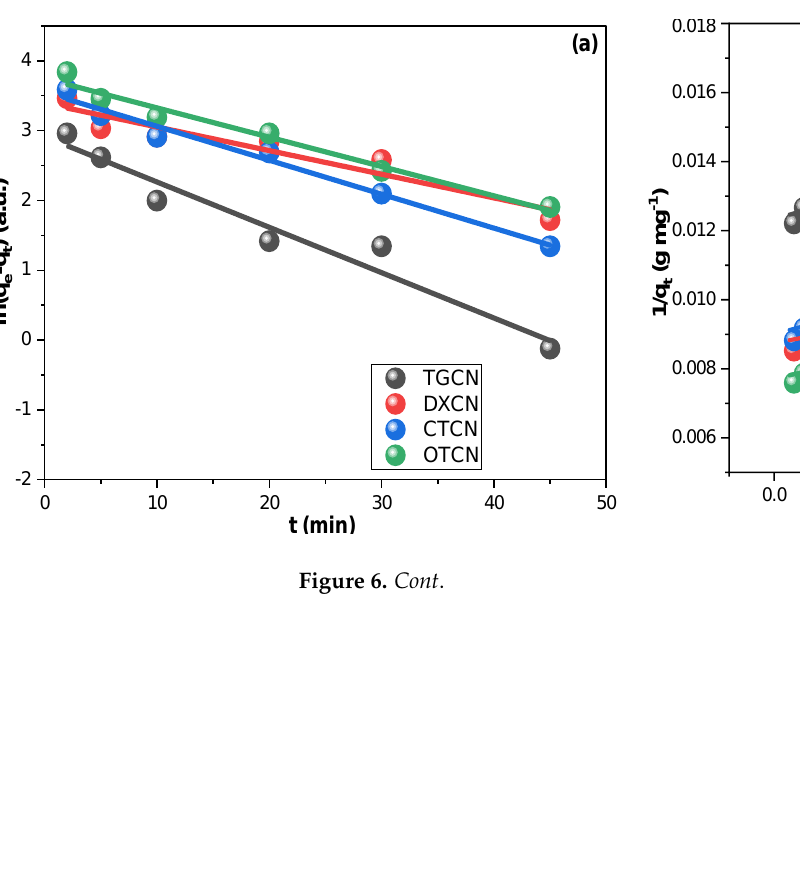
Figure 5. Monitored the chemical structure of ( a ) TGCN, ( b ) DXCN, ( c ) CTCN, and ( d ) OTCN.